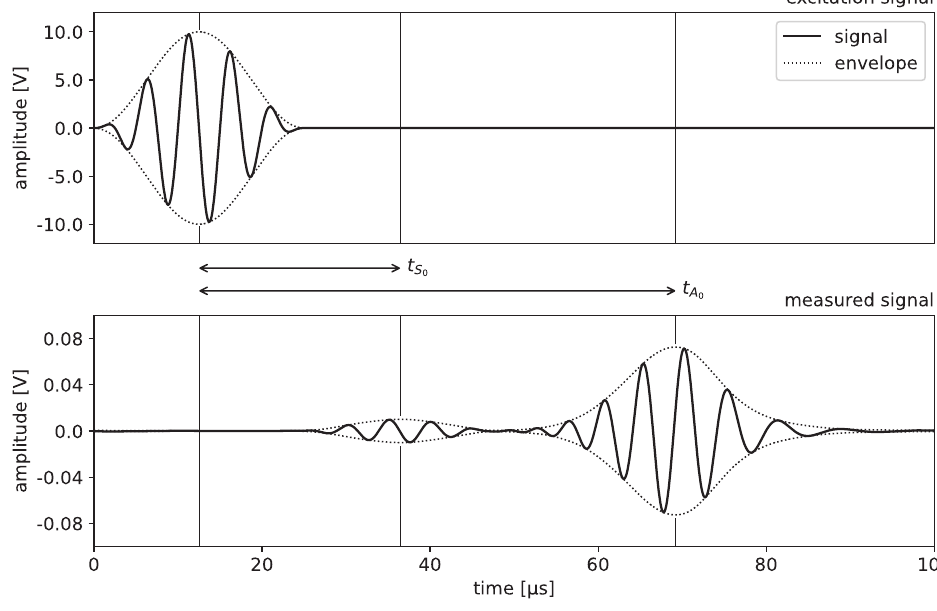
Figure 2. Determination of propagation times of the fundamental Lamb